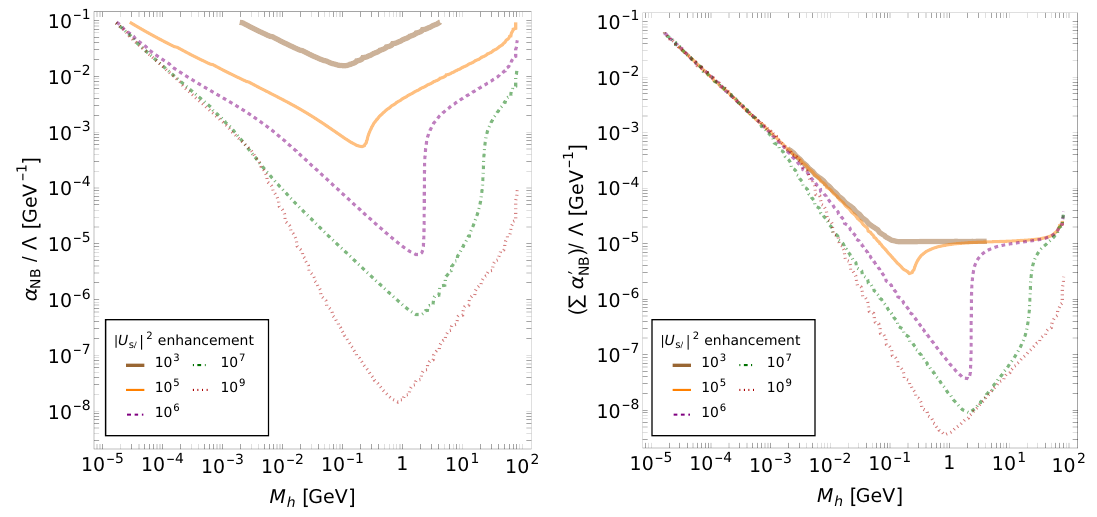
Figure 4 . LEP bounds on ( α NB ) 56 / Λ . On all plots, we show the bound for | U s‘ | 2 enhancements of 10 3 , 10 5 , 10 6 , 10 7 and 10 9 in brown (thick), orange (thin), purple (dashed), green (dot-dashed) and red (dotted) lines, respectively. On the left panel we show the bound on the parameter itself, while on the right panel we display the bound on P ( α 0 ) / Λ NB